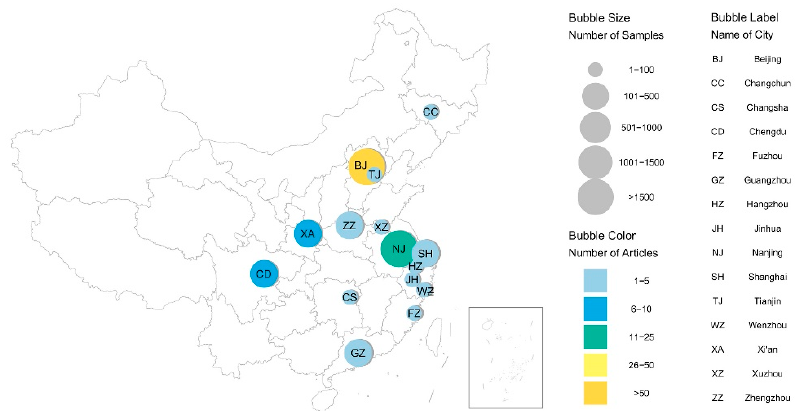
Figure 2. Map of regional distribution and number of articles.